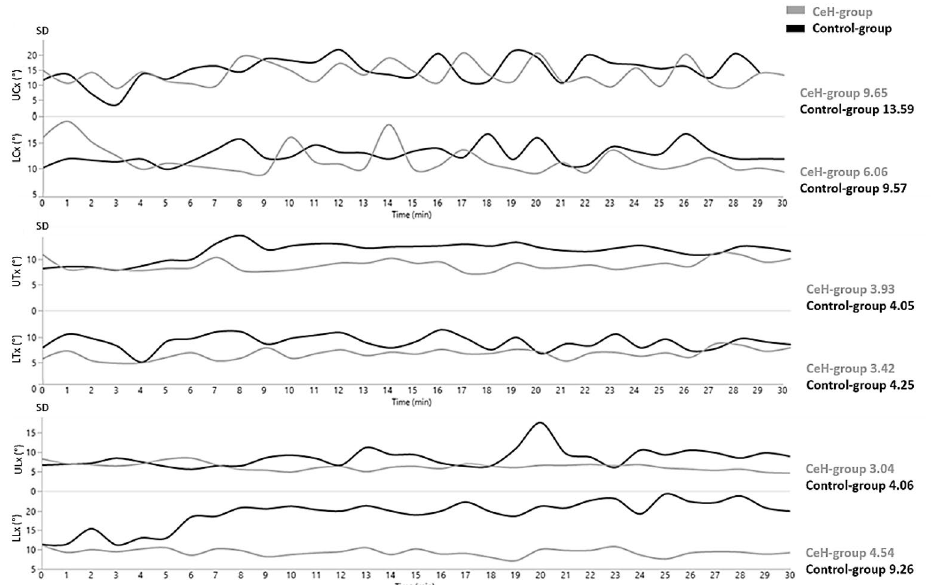
Figure 3. Visualisation of SPV (expressed by SDs) during the 30-min-laptop-task in the CeH-group and control-group (SD = Standard Deviation; ° = degrees; min = minute; mean SDs are reported on the right chart side).